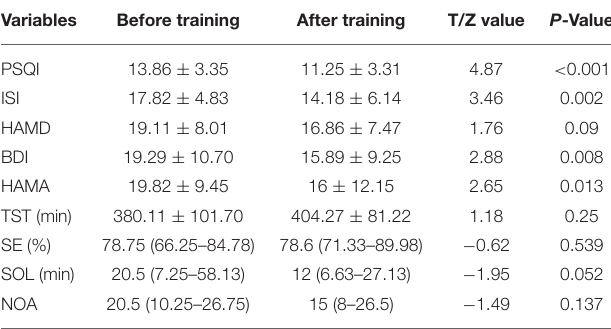
TABLE 1 | Changes in clinical variables before and after training in patients with chronic insomnia disorder. Variables Before training